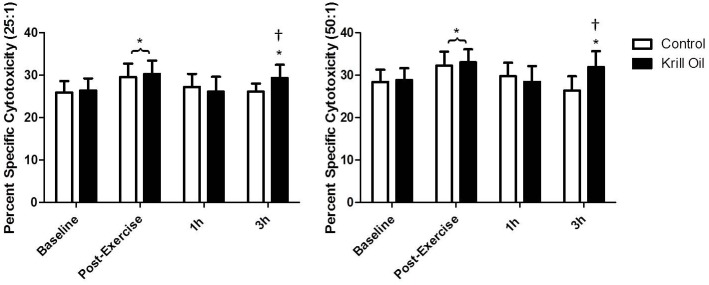
The effect of 6 weeks krill oil/placebo supplementation on NK cell cytotoxic activity at 50:1 and 25:1 effector:target cell ratio, before and after exercise.* indicates significant difference (P<0.05) from baseline values. † indicates significant difference between groups.